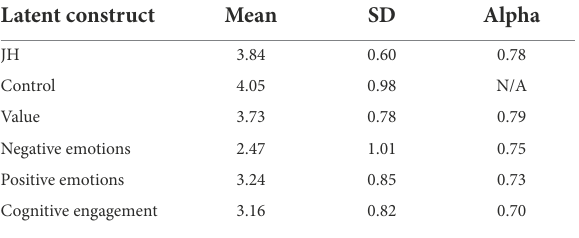
TABLE 1 Means and standard deviations.